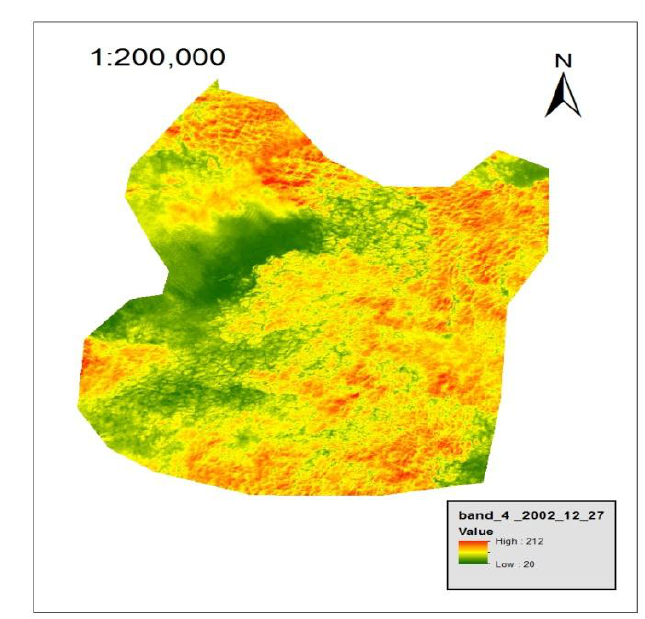
Fig.6: Show image extraction of band (4) for study area in date (27/12/2002). 1- Calculate the value of (NDVI) for applying the Eq.(1) and The result study area by using the tool (raster show in calculator) in Arcmap program through